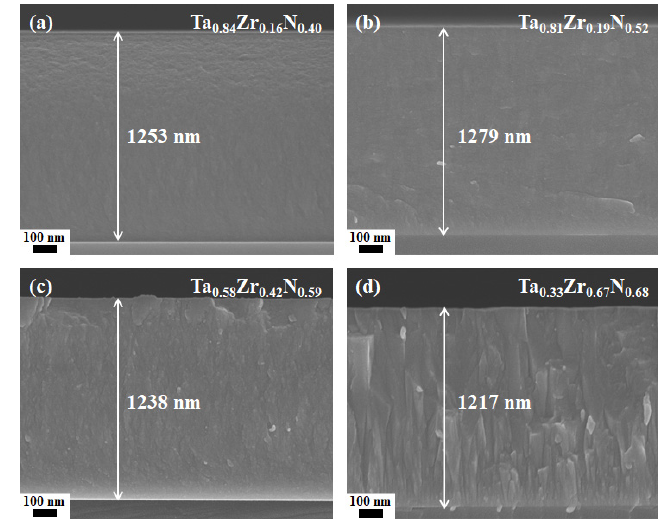
Figure 4. Cross ‐ sectional SEM images of as ‐ deposited Ta–Zr–N thin films prepared on Si substrates. ( a ) Ta 0.84 Zr 0.16 N 0.40 ; ( b ) Ta 0.81 Zr 0.19 N 0.52 ; ( c ) Ta 0.58 Zr 0.42 N 0.59 ; ( d ) Ta 0.33 Zr 0.67 N 0.68 .